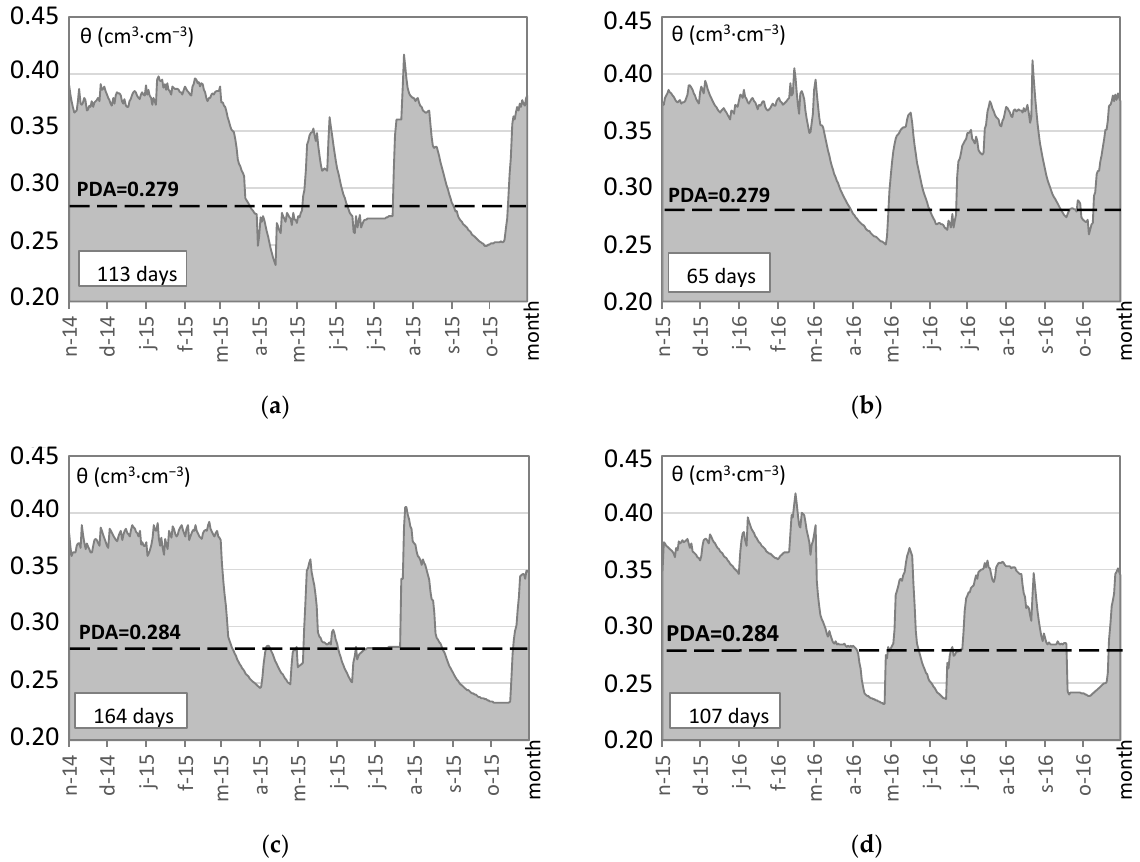
Figure 5. Seasonal changes in the volumetric water content (cm 3 ·cm − 3 ) ( a ) in the B/C1 horizon in HY 2015 and ( b ) in HY 2016, ( c ) in the B/C2 horizon in HY 2015 and ( d ) in HY 2016 and their relation to the PDA hydrolimit (dashed line). The sum of the days under the WP is stated in the box under the dashed line. Table 6. Summary of the occurrences of days with water contents under the PDA hydrolimit.